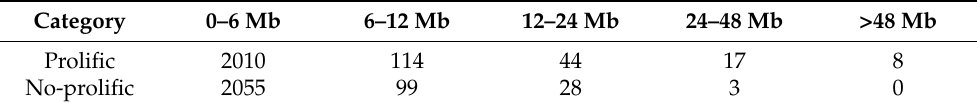
Figure 4. Manhattan plot of the frequencies (%) of SNPs in homozygosity runs in non-prolific Pelibuey sheep. Table 4. Summary of the number of runs of homozygosity (ROH) in different categories in